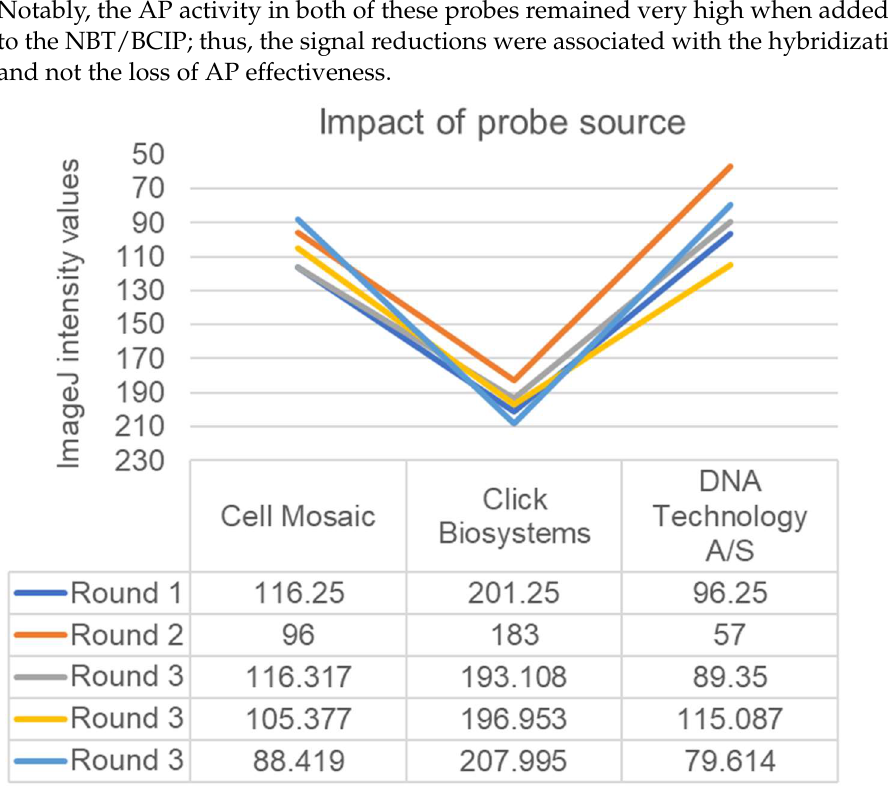
Figure 2. ImageJ intensity values for AP- tdh probes purchased from three different sources. Signals resulting from Cell Mosaic and the previous DNA Technology A/S probes were both significantly lower (and thus signals were stronger) than those produced in our hands at this time by the Click Biosystems probes ( p < 0.05), and they were not significantly different from each other ( p > 0.05). When assessing the impacts of blocking conditions, we compared Roche Blocking Reagent (RBR) with milk and casein (Figure 3). Comparing the use of RBR with or without milk to the use of milk alone yielded no statistically significant differences ( p >